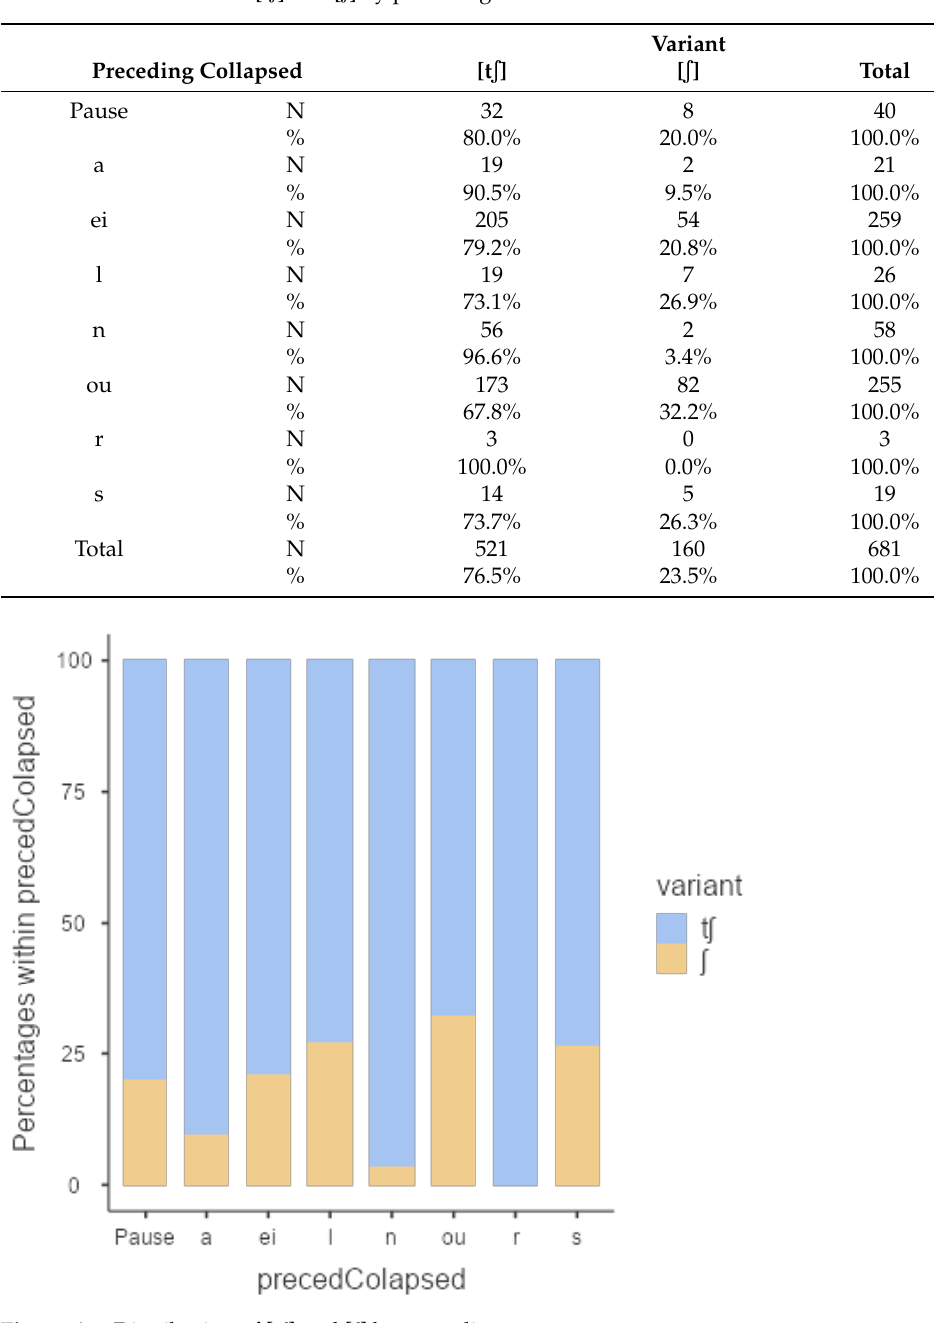
Table A1. Distribution of [t S ] and [ S ] by preceding context.